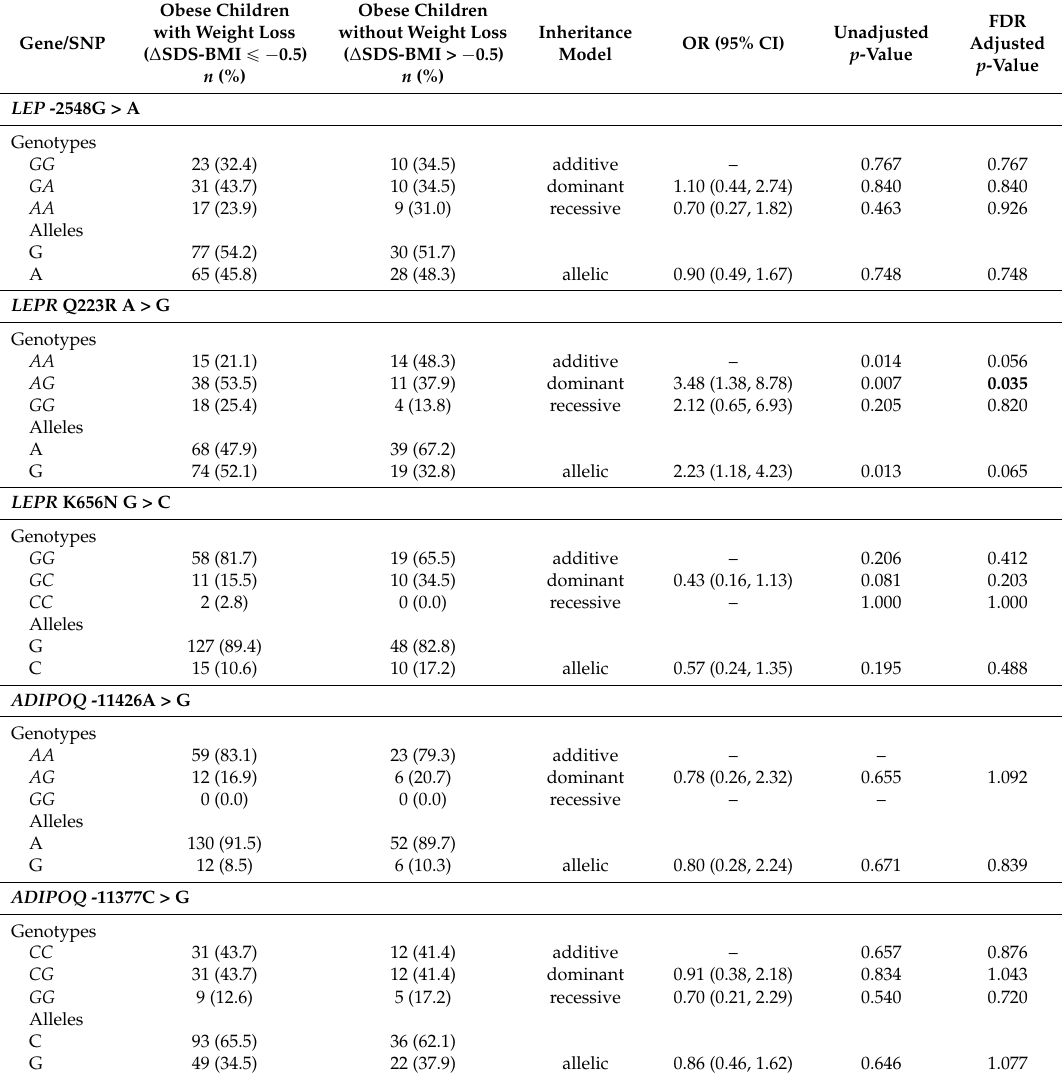
Table 1. Distribution of LEP , LEPR , and ADIPOQ genotypes and alleles in prepubertal obese children with or without weight